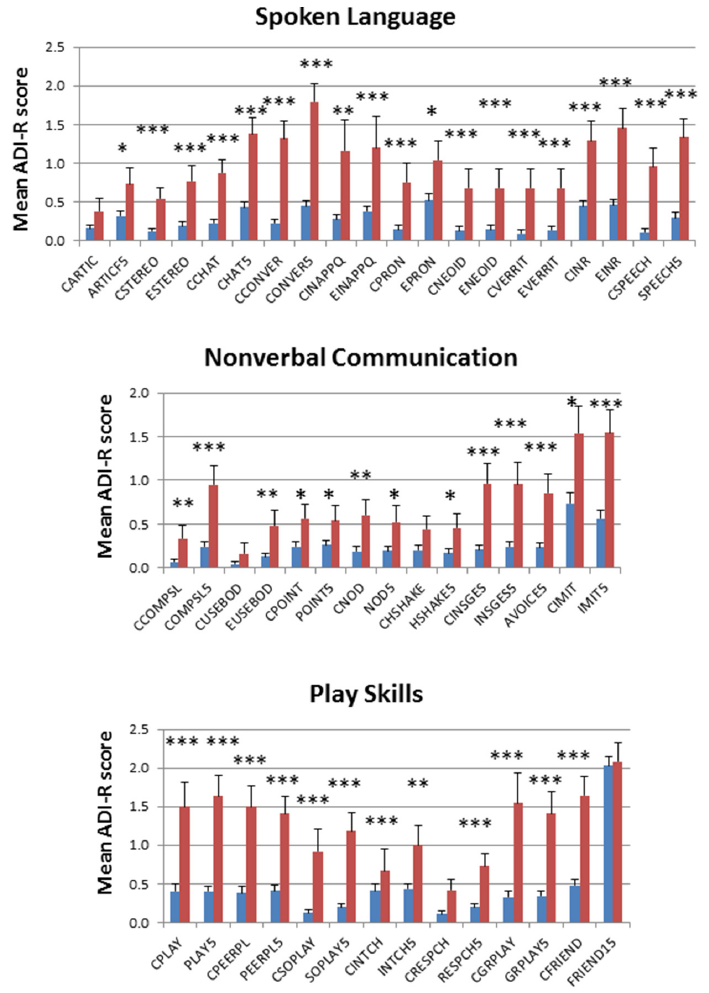
Figure 2. Boxplots showing range of trait scores of all twin groups. Student’s t -test was used to show that there were significant differences between the trait scores for dNA.MZ and dNA.DZ twins. *** p -value ≤ 0.001.